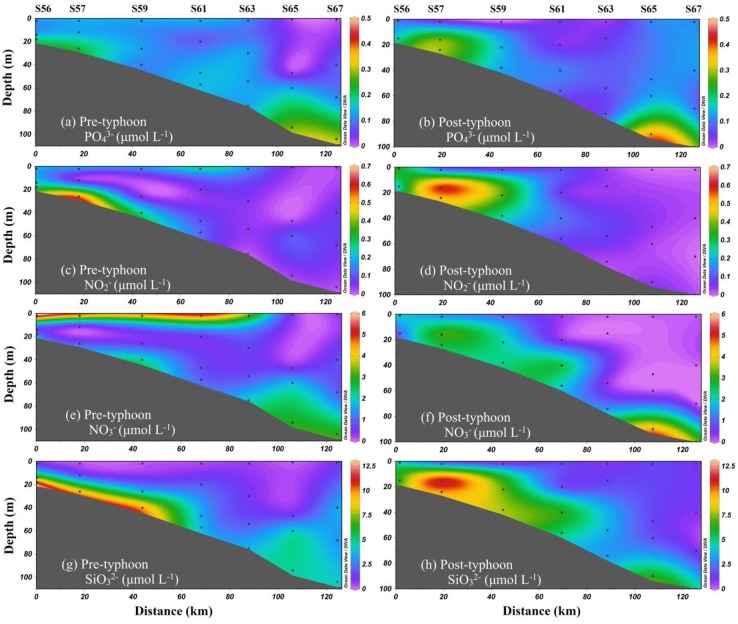
Spatial distributions of NO3-, NO2-, SiO32- and PO43- on sampling sites during the pre- and post-typhoon periods.